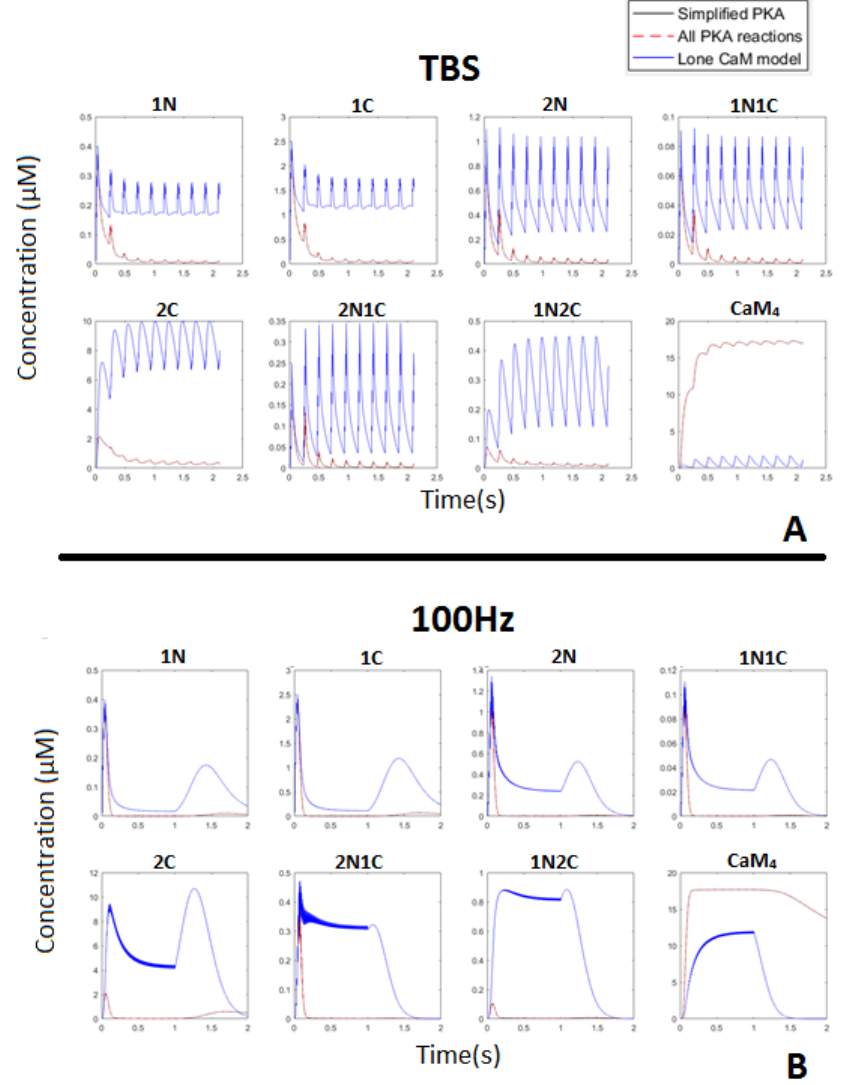
Figure 5. CaM states during the TBS ( A ) and 100 Hz ( B ) stimulation. Notice that each partially bound state’s peak rapidly decayed in the full CaM-binding system, unlike in the lone CaM model, where calcium bound to either single or multiple sites (i.e., <4). This was because the stability of bound CaM increases when all the sites are bound to Ca 2+ , i.e., partially bound CaM trends towards instability.